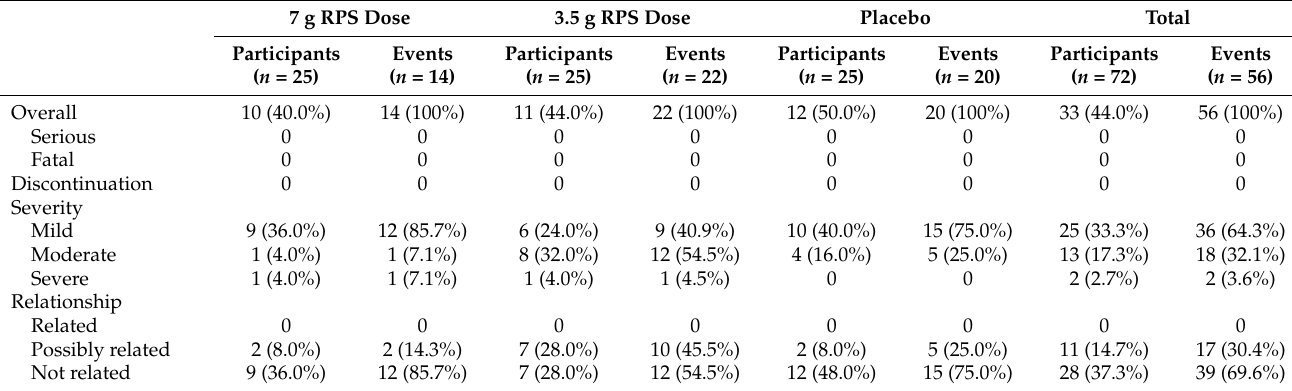
Table 6. Summary of TEAEs in the FAS